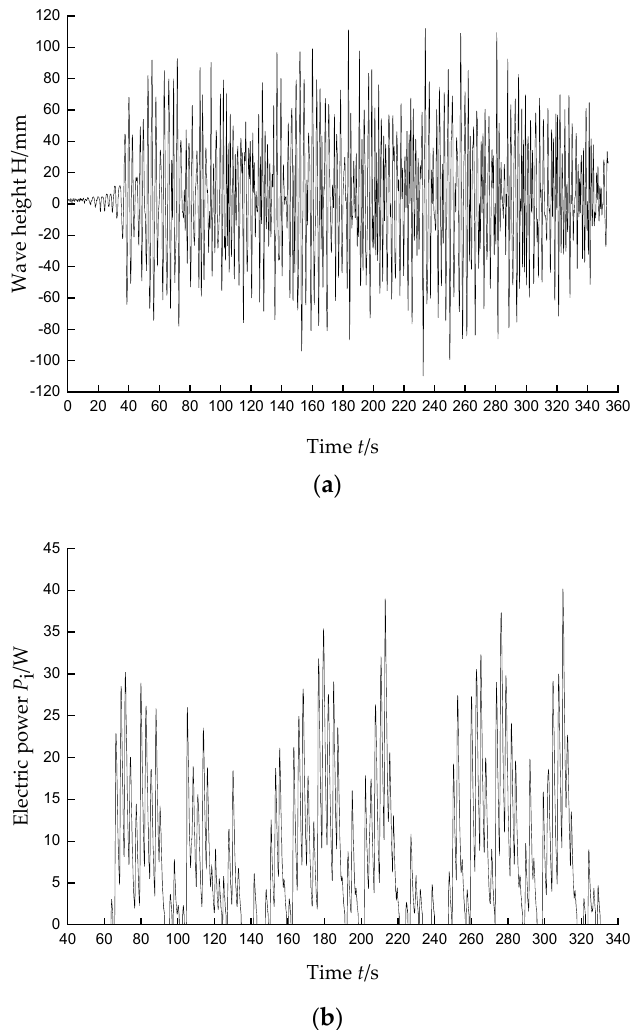
Figure 8. The data of wave height and electric power with maximum wave-wire conversion ratio.